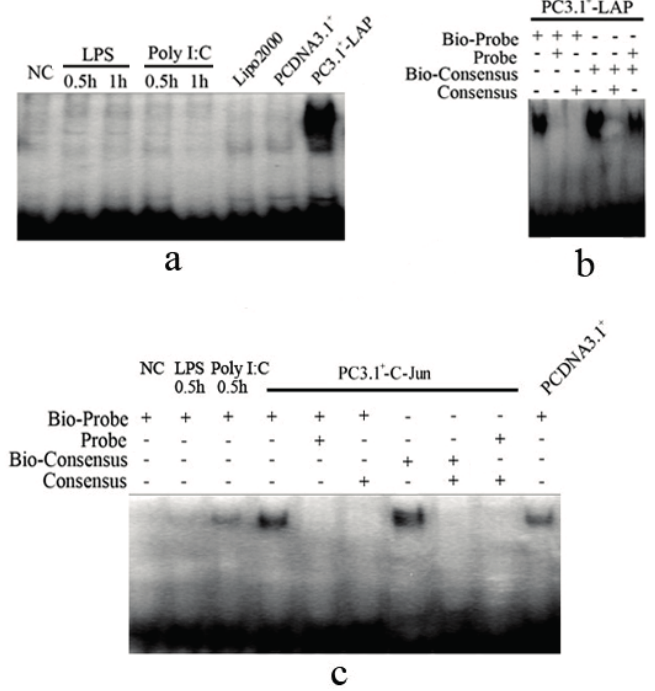
Figure 4. EMSA results for C/EBP β and AP-1 binding. ( a ) The EMSA of C/EBP β . The binding ability of C/EBP β was increased sharply when LAP was overexpressed and it was not altered after stimulation with LPS or Poly I: C. Lipo2000 indicates PK-15 cells treated only with Lipofectamine™ 2000, which was used as a negative control; ( b ) The EMSA of C/EBP β containing the unlabeled competitive probe. The binding of LAP could be competitively inhibited by 100-fold excess unlabeled competitive C/EBP β probe of S100A12 or by 100-fold excess unlabeled consensus probe of C/EBP β . Bio-probe indicates a C/EBP β probe of S100A12 labeled with biotin; probe indicates a C/EBP β probe of the porcine S100A12 gene without biotin labeling, which was used in a competition reaction; Bio-consensus indicates the consensus probe of C/EBP β labeled by biotin; Consensus indicates the consensus probe of C/EBP β without biotin labeling, which was used as competition reaction; ( c ) The EMSA of AP-1. The binding ability of AP-1 was increased obviously when C-Jun was overexpressed compare to PCDNA3.1 + group and it was slightly increased when treated with Poly I: C or LPS for 30 min compare to the NC group. The binding ability of AP-1 could be inhibited by 100-fold excess unlabeled competitive probe of S100A12 or by 100-fold unlabeled competitive consensus probe of AP-1. Bio-probe indicates the AP-1 probe of the porcine S100A12 gene labeled with biotin; probe indicates the AP-1 probe of porcine S100A12 gene without biotin labeling, which was used in competition reactions; Bio-consensus indicates the consensus probe of AP-1 labeled by biotin; consensus indicates the consensus probe of AP-1 without biotin labeling, which was used in competition reactions; NC indicates PK-15 cells without any treatment, which were used as negative control for the treatments of LPS and Poly I: C; PCDNA3.1 + indicates PK-15 cells transfected with the PCDNA3.1 + vector, which was used as negative control for the overexpression of C-Jun; PC3.1 + -LAP and PC3.1 + -C-Jun indicate that LAP and C-Jun were overexpressed,